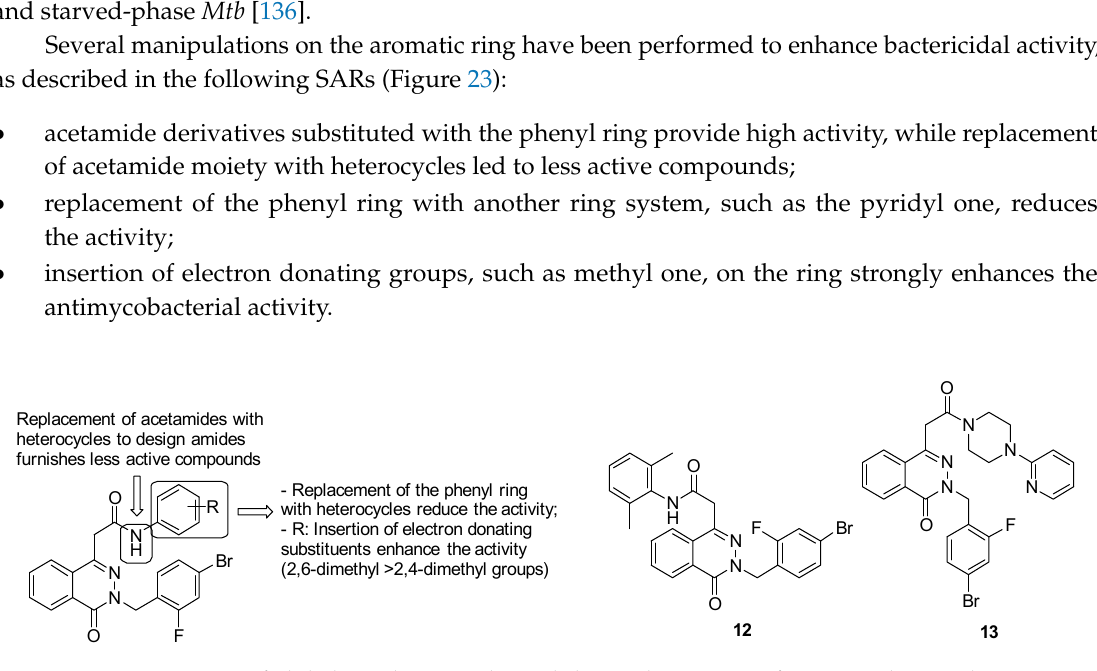
infected mice at 25 mg⁄kg and unfortunately showed diminished anti-TB activity in the lung and spleen (log CFU values of 6.61 and 6.12, respectively) compared to INH (log CFU values of 5.86 and 4.71,